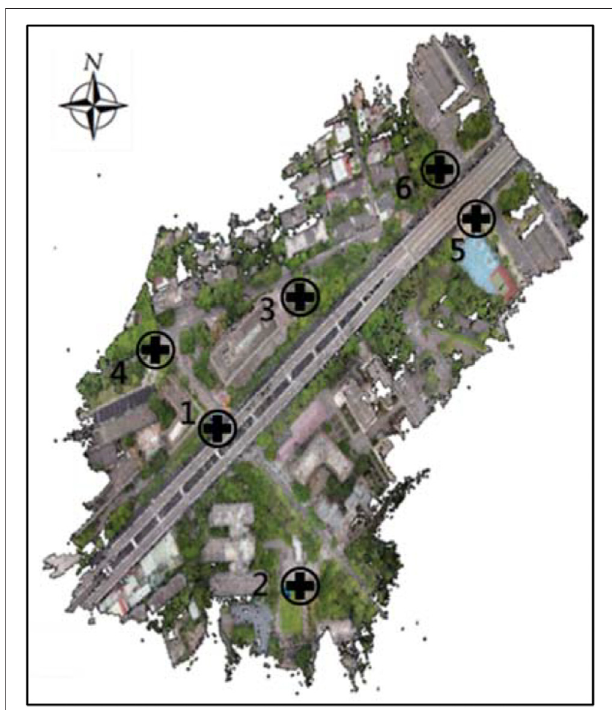
FIGURE 5 | Images taken by UAV and the distribution of the ground control